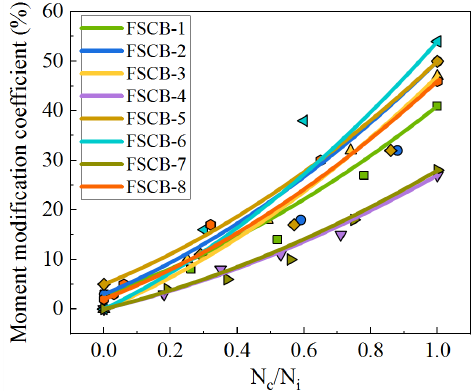
Figure 14. Fi tt ing curves of moment modi fi cation coe ffi cient. Table 7. Fi tt ing accuracy of Equation